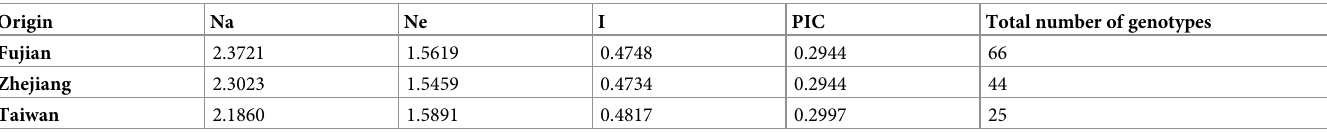
Table 4. The number of alleles (Na), effective number of alleles (Ne), Shannon’s Information index (I) and polymorphism information content (PIC) of genotypes from Fujian, Zhejiang and Taiwan estimated by 43 SSR markers. Origin